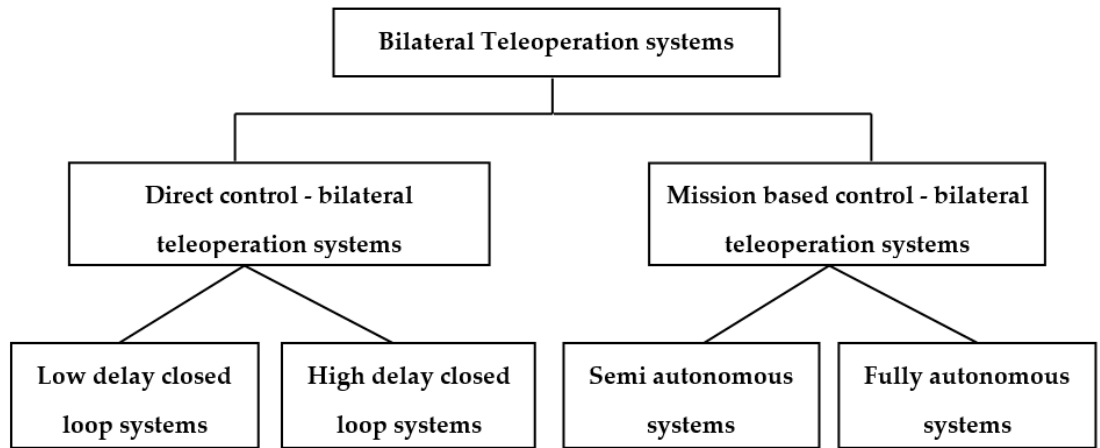
Figure 4. Classifications of bilateral teleoperation systems.